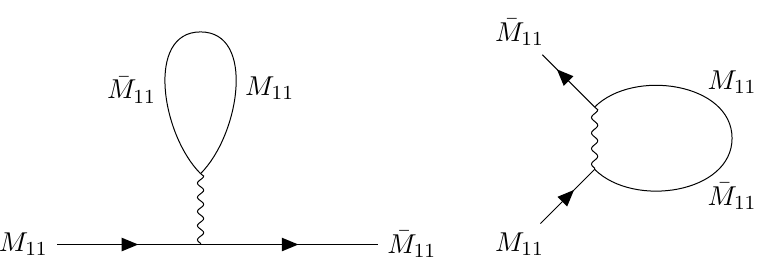
Figure 5. The solid line represents the propagator of the light (cid:12)elds (or the corresponding moduli) and the curvy line is V as it emerges from a blow up of the e(cid:11)ective vertex (crossed circle) in (cid:12)gure